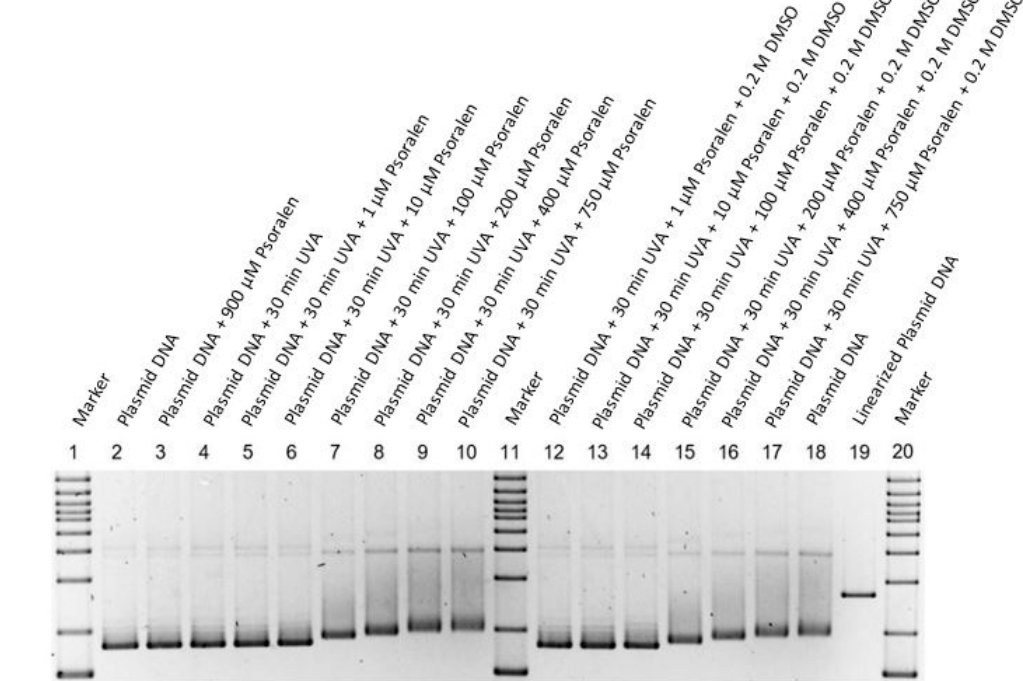
Figure 4. Fluorescent measurement of an agarose gel for combining psoralen with UV-366 nm with an additional 0.2 M DMSO for several lanes. The figure is inverted, thus showing a dark color for high intensities. Markers are placed in lanes 1, 11, and 20. Lane 2 and 18 show the untreated plasmid, whilst lane 19 contains the linear plasmid. In lanes 4–10 and 12–17, different psoralen concentrations (0, 1, 10, 100, 200, 400, 750 µM) were irradiated with UV-366 nm for 30 min, where an additional 0.2 M DMSO was present in lanes 12–18. Each lane was normalized and shows the running behavior of the different setups. In comparison to Figure 1, the additional DMSO did not produce a different behavior. Lane 3 demonstrates non-UV-activated psoralen (900 µM).